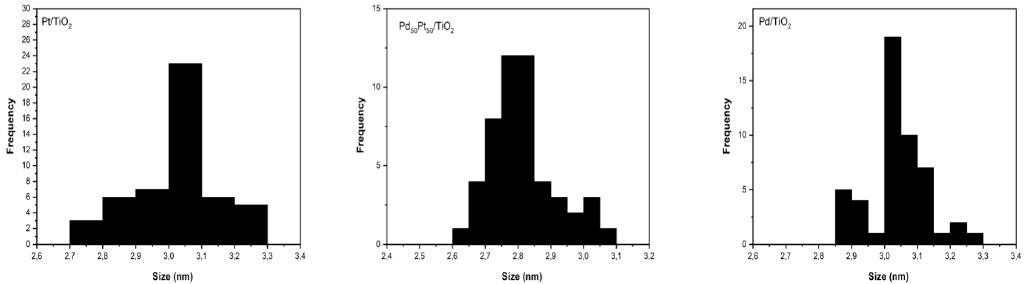
Figure 3. TEM particle size distribution of for mono and bimetallic samples.